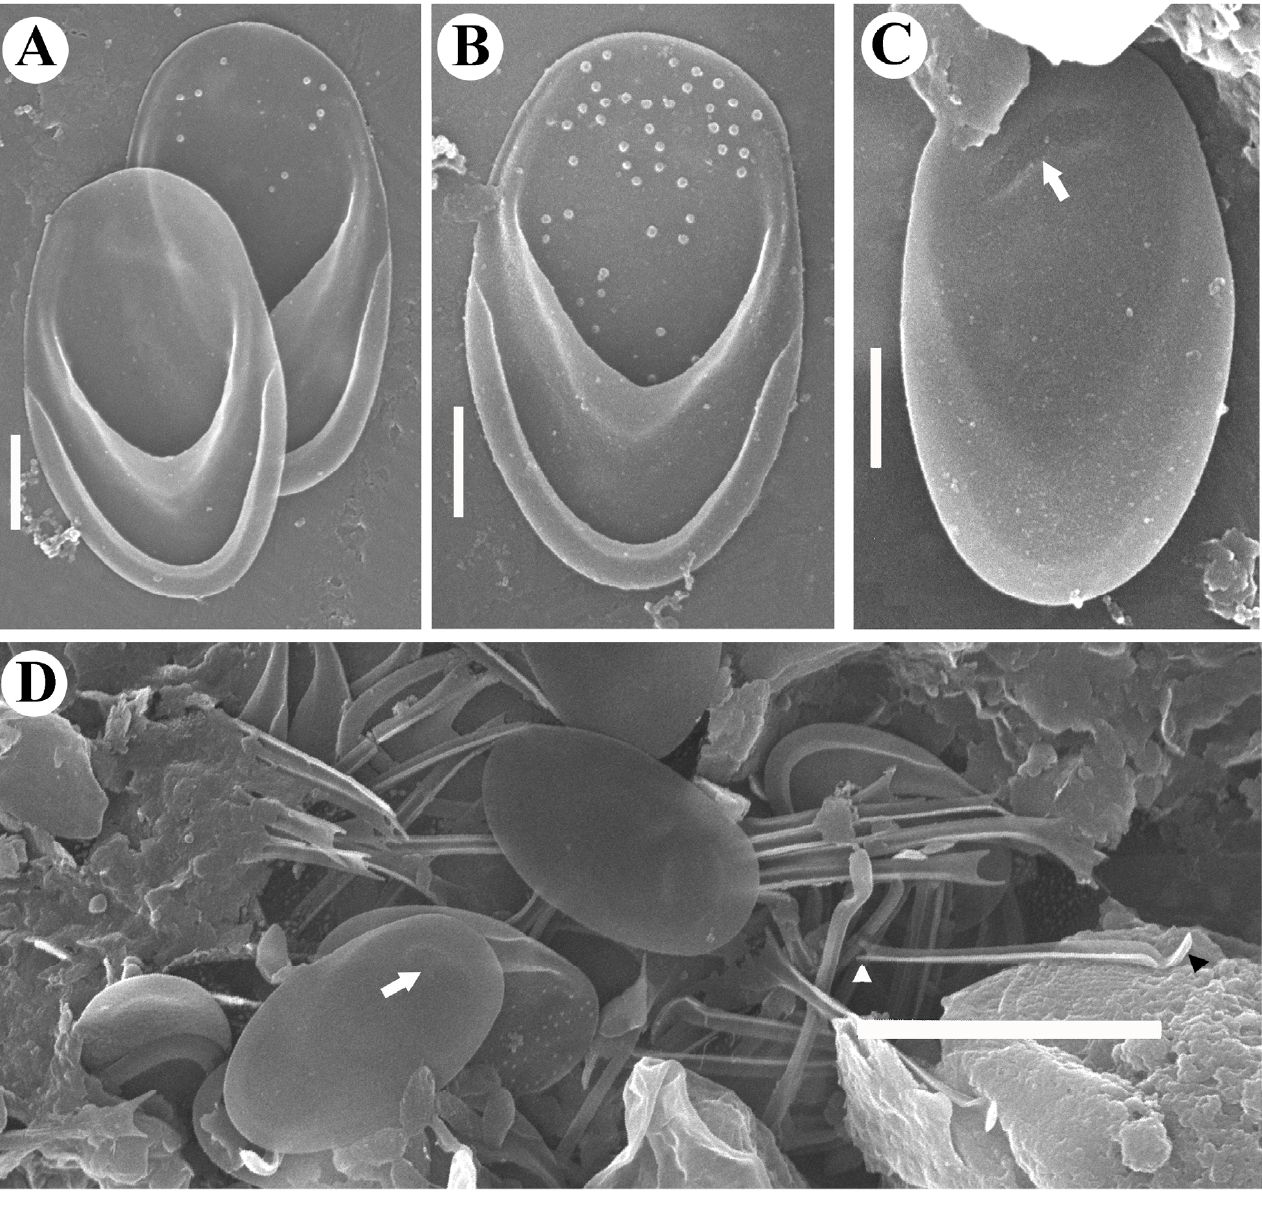
Figure 5. ( A – D ) Scales and bristles of Mallomonas preisigii , SEM. ( A ) Two scales with (in the back- ground) or without (in the foreground) papillae. ( B ) A scale covered with papillae. ( C ) Undersurface of the scale illustrating the shallow concavity (arrow). ( D ) A group of scales and bristles (an arrow indicates the shallow concavity on the scale, a white arrowhead indicates the bristle tip and a black arrowhead indicates the bristle foot). Scale bars: ( D ): 5 µ m, ( A – C ): 1 µ